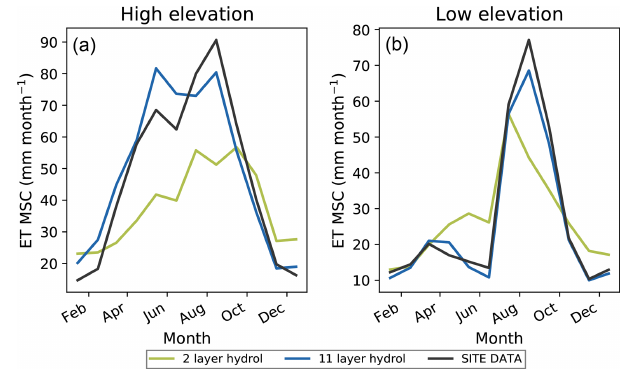
Figure 3. Evapotranspiration (ET) monthly mean seasonal cycle comparing the 2LAY (green curve) and 11LAY (blue curve) sim- ulations with observations (black curve). Individual site simula- tions have been averaged over the high-elevation tree-dominated sites (a) and across all the low-elevation grass- and shrub-dominated sites (b) . Units are millimeters per month (mmmonth − 1